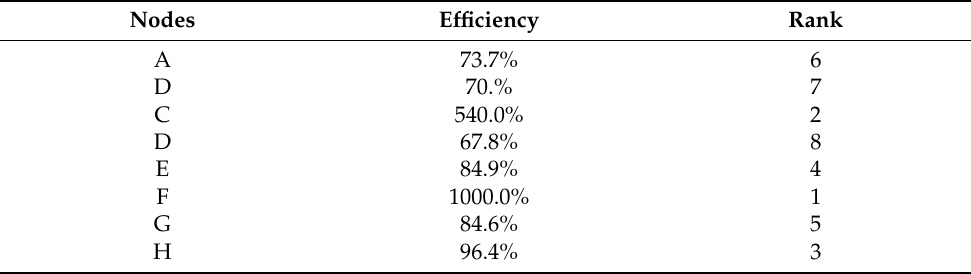
Table 2. The efficiency and rank of nodes by data envelopment analysis (DEA). Nodes